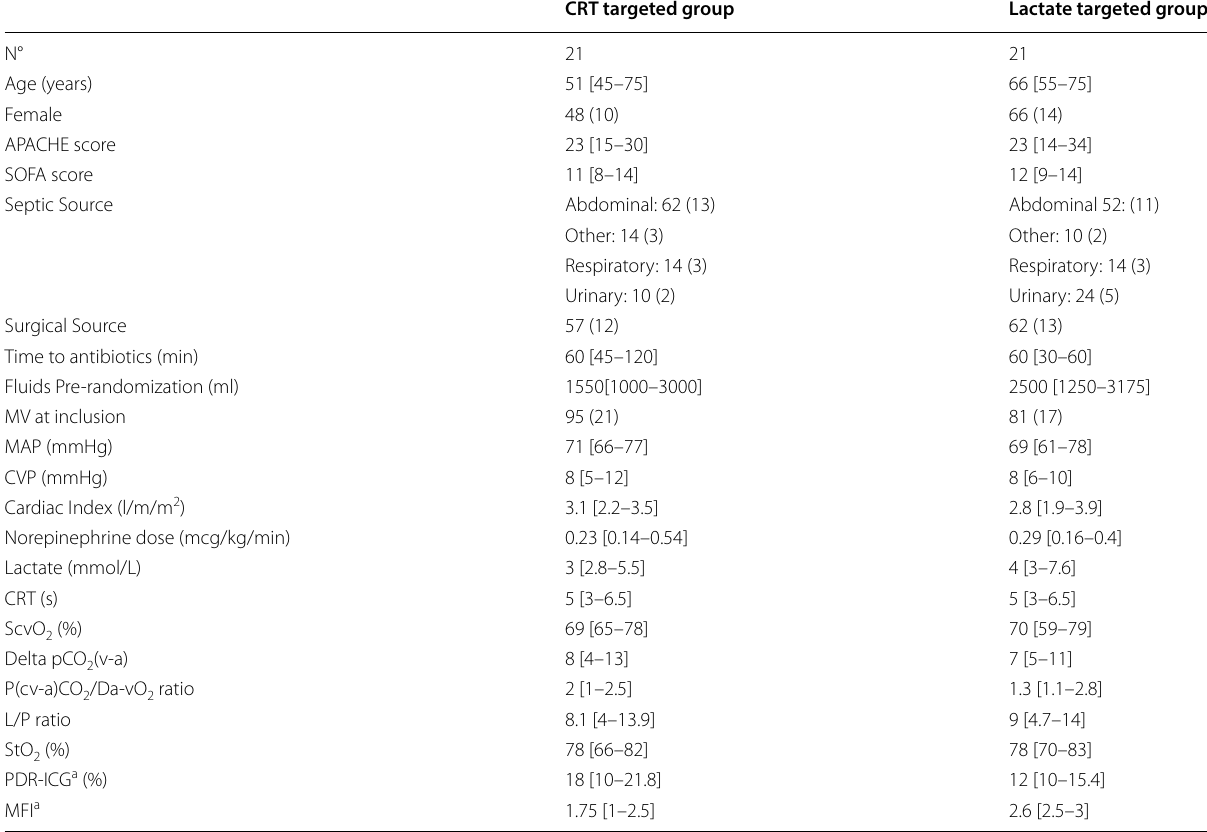
Table 1 Baseline characteristics of the study